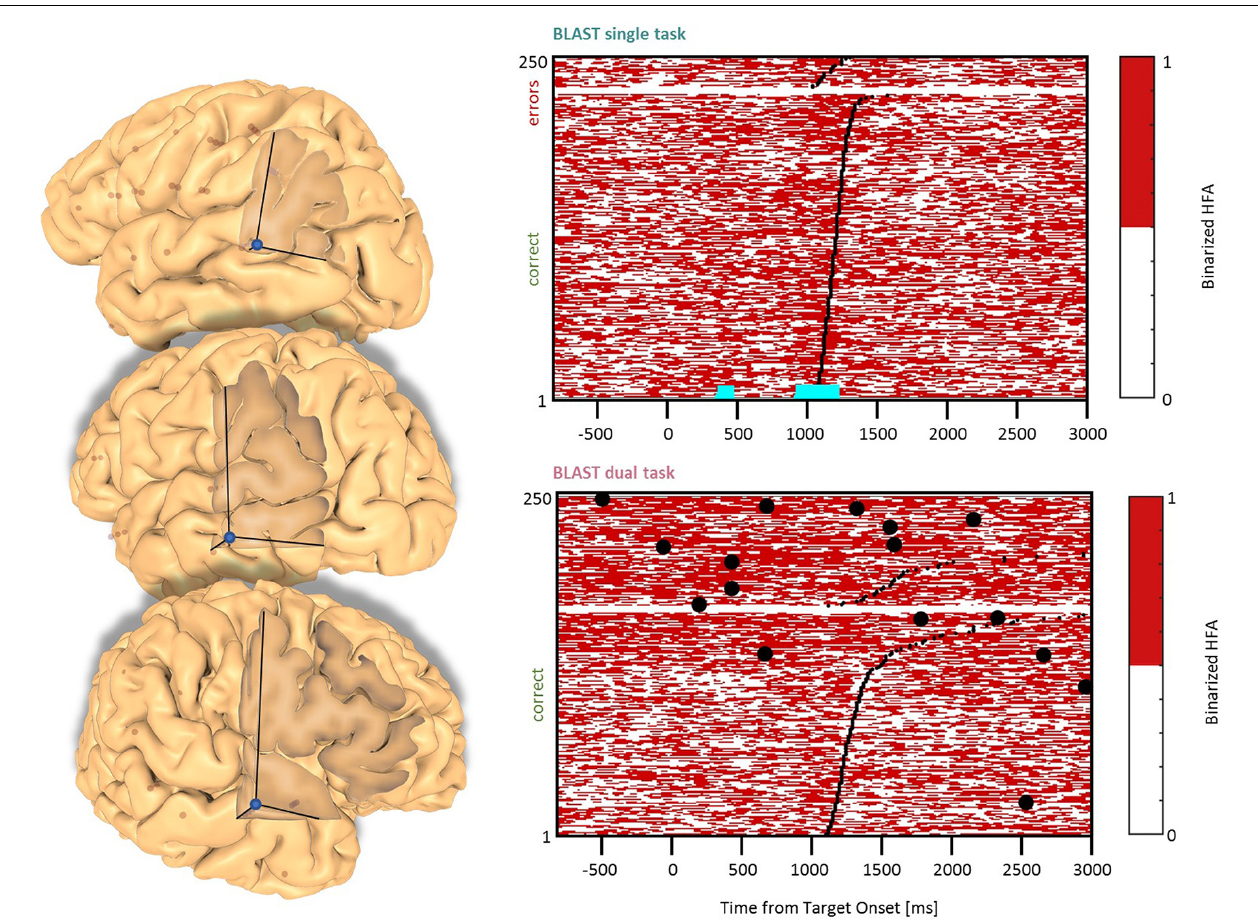
FIGURE 8 | Interference in the Lateral Temporal Cortex. Sites with interference between T1 and T2 are displayed at their precise anatomical location onto a 3D representation of the participant’s brain. The matrix representation reproduces the display of Figure 2 , for the single-task and dual-task conditions for one of the sites. Patients id [Px] and iEEG site names, from left to right and top to bottom: D’7 [P6]; C’12 [P11] (matrix displayed); A9